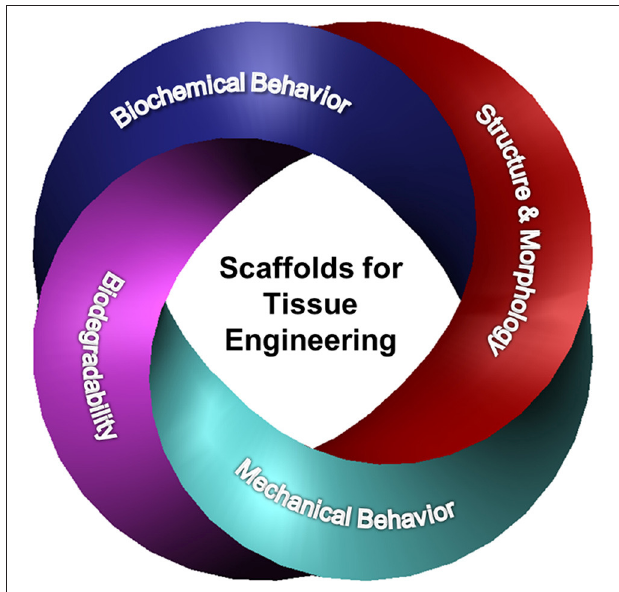
FIGURE 9 | Synergy between biochemical behavior, structure and morphology, biodegradability, and mechanical behavior of scaffolds activates cellular behavior, controls cell fate, and drives TE